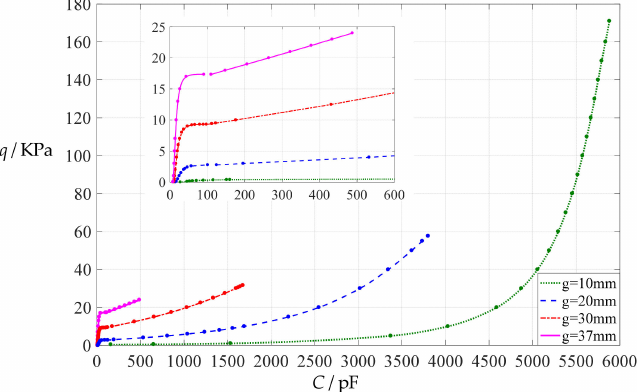
Figure 2. The input capacitance-output pressure relationships of a circular capacitive pressure sensor from non-touch mode of operation to touch mode of operation, where a = 100 mm, h = 1 mm, t = 0.1 mm, E = 7.84 MPa, ν = 0.47 and the initial air parallel gap g takes 10 mm, 20 mm, 30 mm, and 37 mm, respectively.